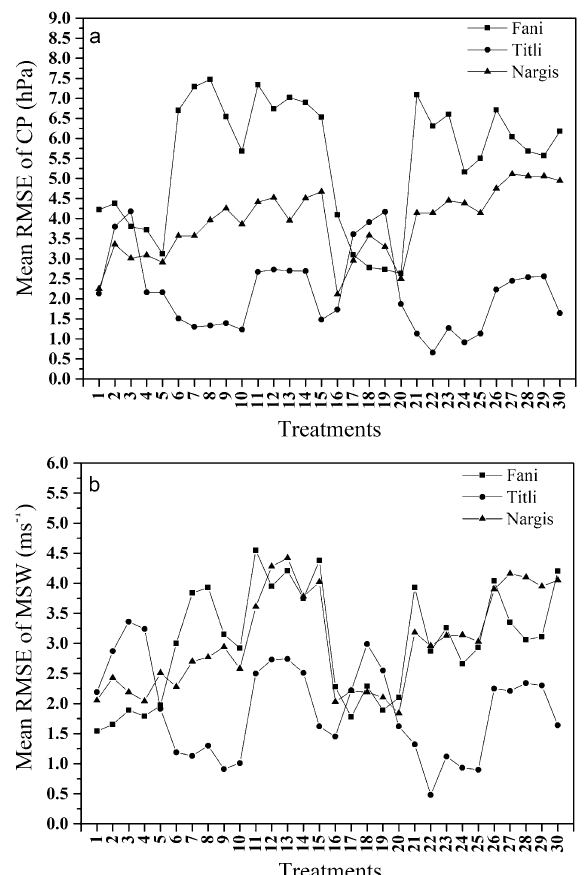
Figure 1. Root mean square (RMS) error averaged for the entire simulation period for ( a ) central pressure and ( b ) MSW for cyclone Fani, Titli and Nargis.